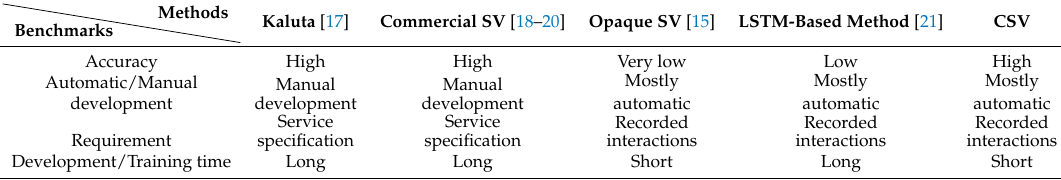
Table 4. Comparison between different SV methods on generating non-categorical numeric fields.